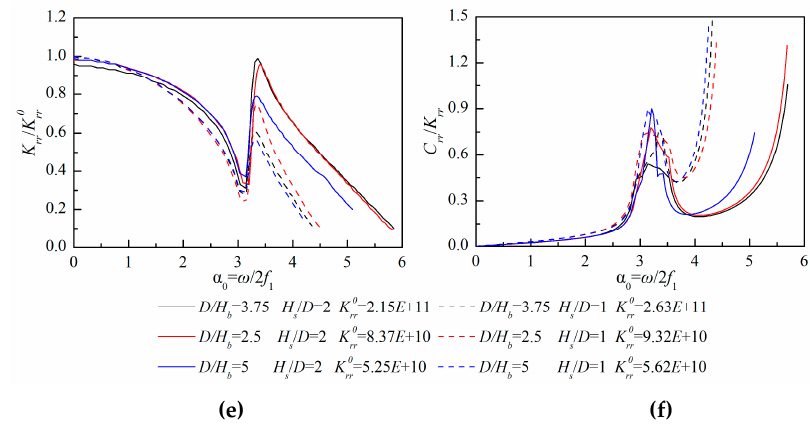
Figure 12. Variation of three dynamic impedance coefficients with respect to the dimensionless frequency under the effect of the relative thickness of the soil layer: ( a ) Horizontal stiffness coefficient; ( b ) horizontal damping coefficient; ( c ) coupling stiffness coefficient; ( d ) coupling damping coefficient; ( e ) rocking stiffness coefficient; ( f ) rocking damping coefficient.